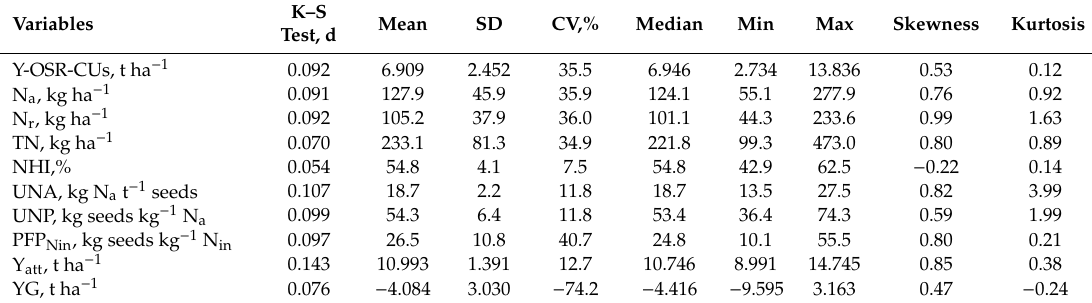
Table 3. Descriptive statistics of WOSR of yield characteristics and indicators of nitrogen